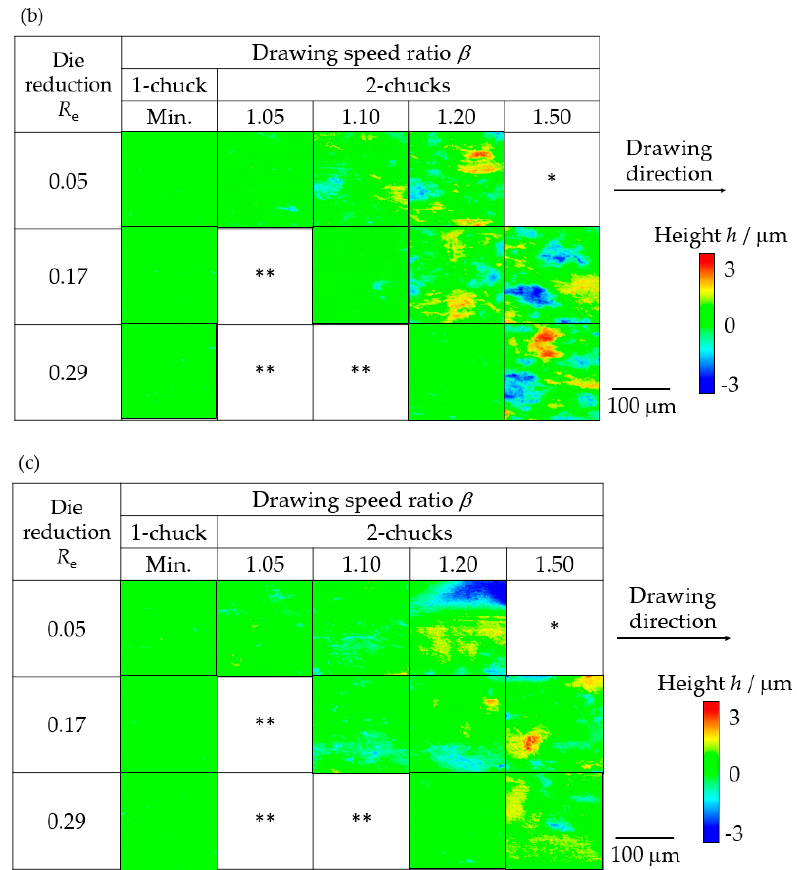
Figure 9. Height maps of the outer surface of the drawn tubes. ( a ) Stainless-steel, ( b ) copper [10], and ( c ) aluminum alloy tubes. 1-chuck implies that only the tube on the exit side was chucked. 2-chucks means that both the tubes on the die entrance and exit sides were chucked. The symbol * indicates that the drawing experiment was not performed. The symbol ** indicates that the drawing experiment was impossible because the drawing speed ratio is less than the minimum value.